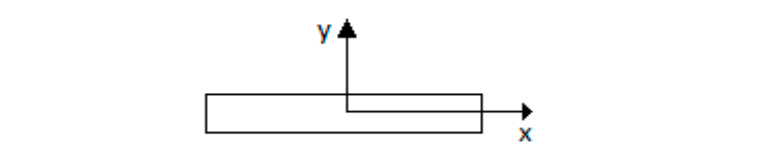
Figure 6. Position of the Cartesian coordinate system plane on the sample.